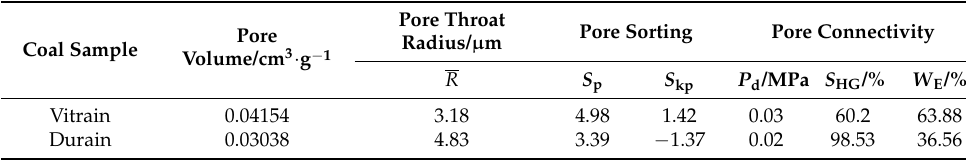
Table 3. Pore characteristics of vitrain and durain